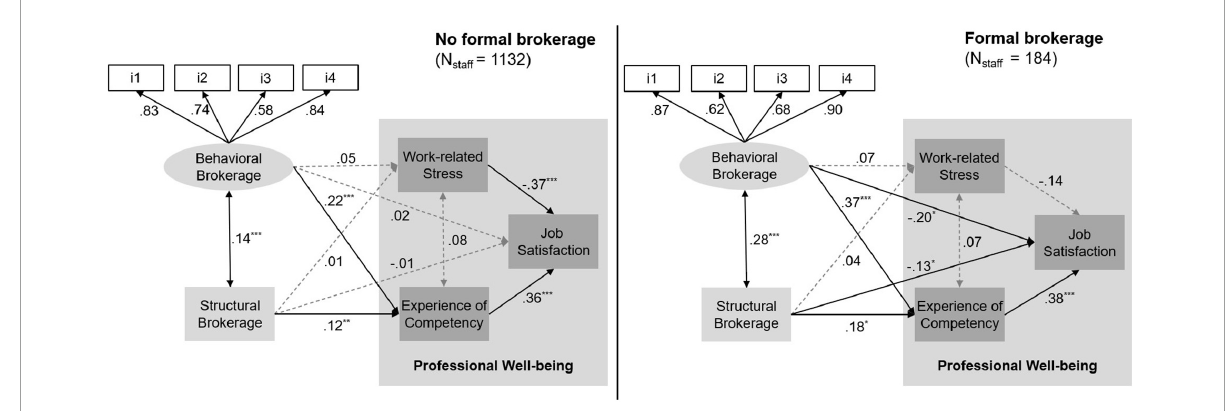
FIGURE2 Results of the multiple group structural equation modeling analysis of formal and non-formal brokerage (cluster = school; MLR). χ 2 (28) = 81.794, p < 0.001, scaling correction factor Yuan-Bentler correction (Mplus variant) = 1.044: CFI = 0.97, TLI = 0.95; RMSEA [90% CI] = 0.062 [0.047 –0.079], SRMR = 0.024. * p < 0.05, ** p < 0.01, *** p <